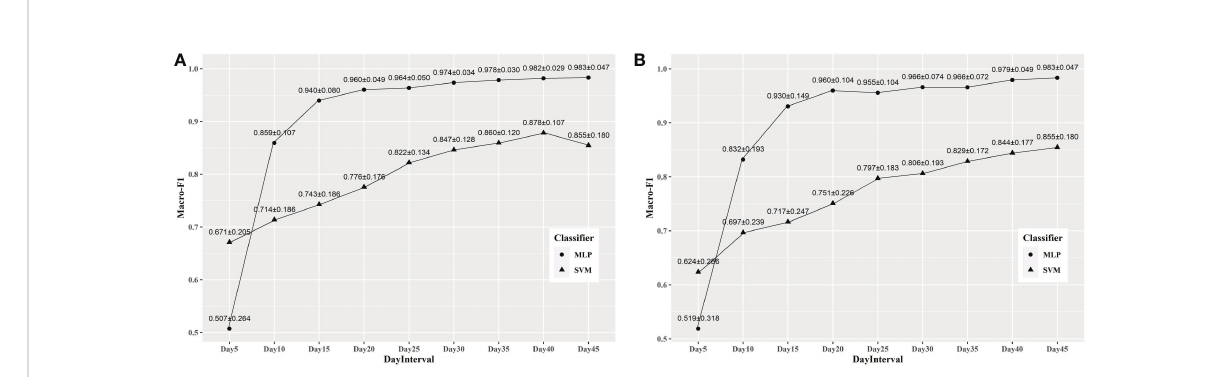
FIGURE 4 The results for prediction using classi fi ers trained by datasets with different size. (A) The results for prediction of the whole images of the rest days; (B) The results for prediction of the images of the 46 th -50 th